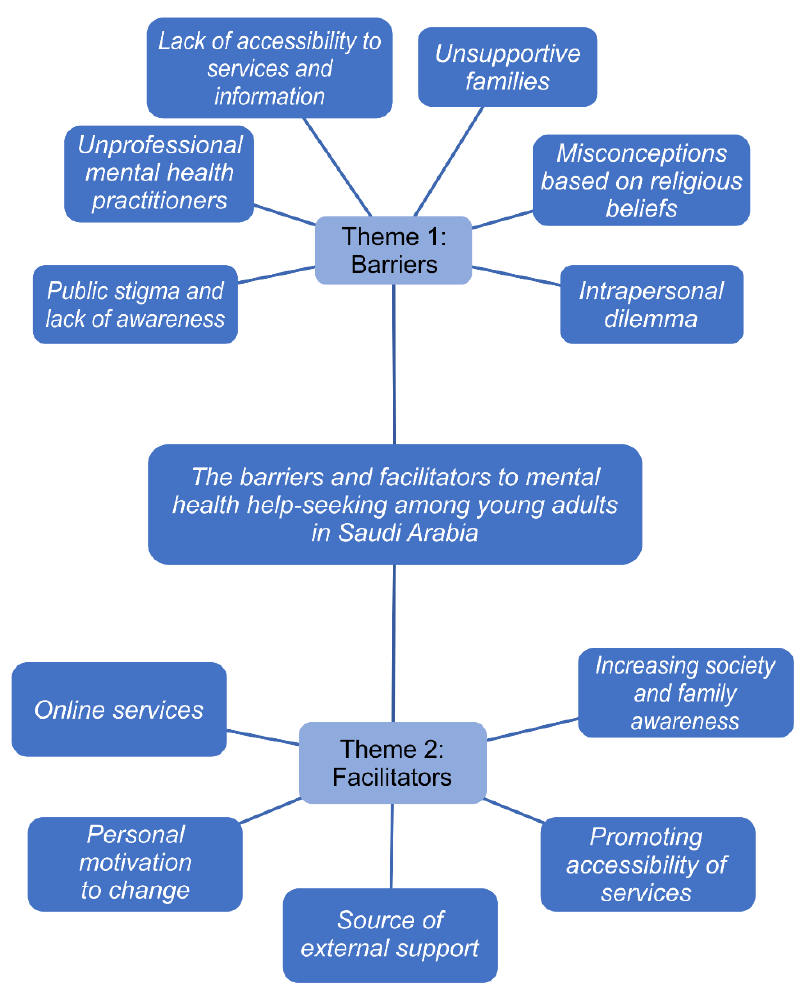
Figure 1. Diagrammatic representation of the results of the thematic analysis of the data .